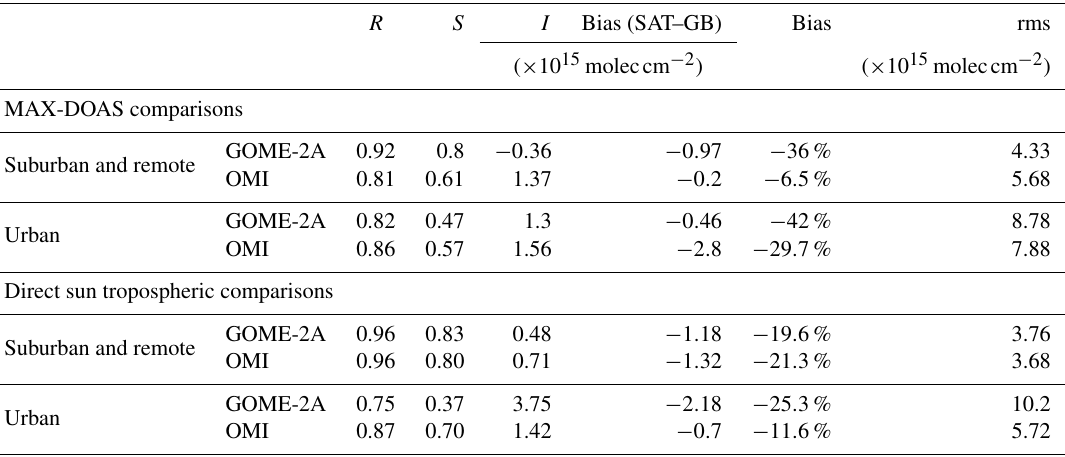
Table 4. Statistics of the monthly median comparisons per station type for the satellite baseline (small pixel over station) versus ground-based comparisons. Linear regression slope S and intercept I are